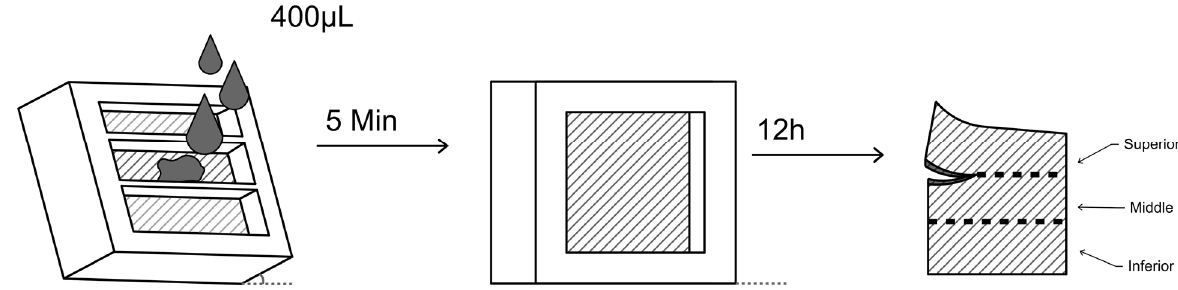
Figure 6. Vertical permeation study schematic rationale, with the formulation application, permeation, and skin division.